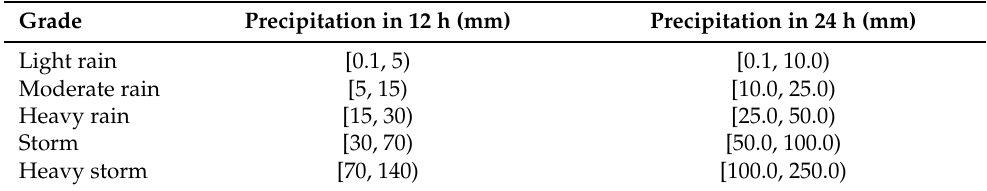
Table 2. Grading of precipitation